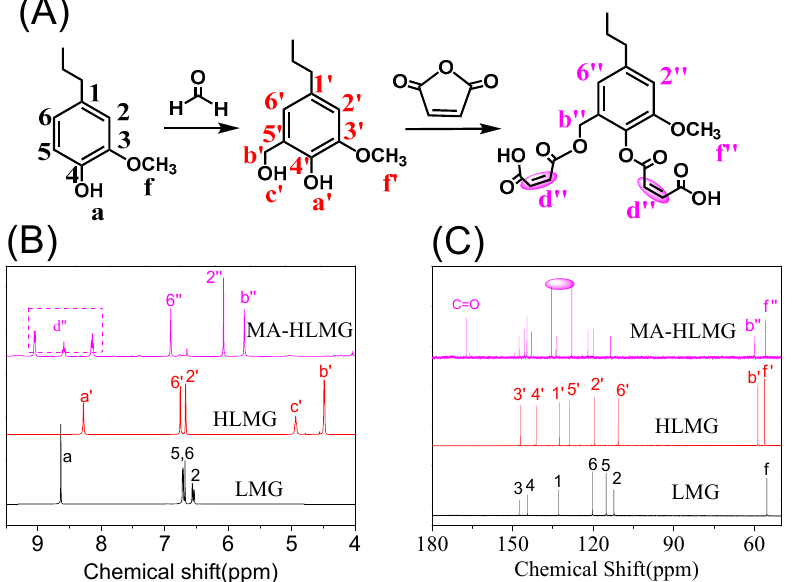
Figure 1. ( A ) Schematic illustration of hydroxymethylation and maleation of model compound 3-methoxy-4-hydroxyphenylpropane (LMG); ( B ) 1 H NMR spectra of LMG and its derivatives hydroxymethylated LMG (HLMG) and maleated HLMG (MA-HLMG); ( C ) 13 C NMR spectra of LMG and its derivatives.